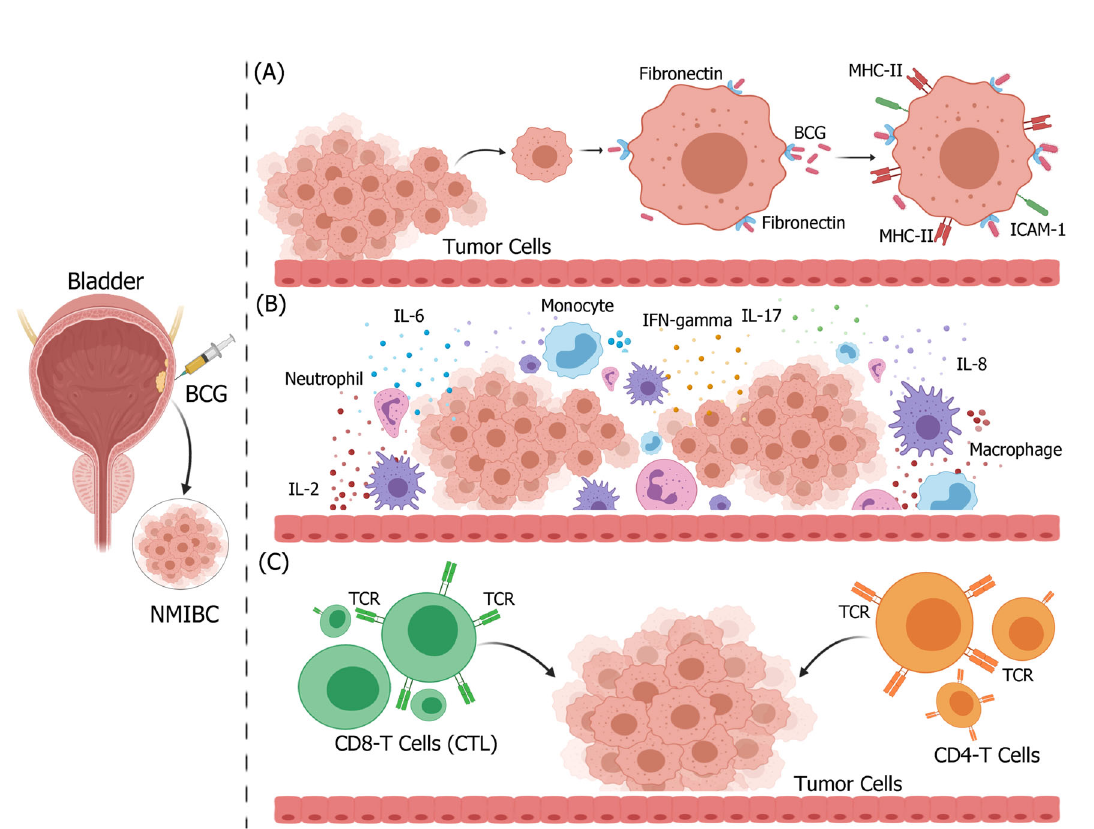
Fig. 3 Possible mechanism of BCG non-speci fi c immunotherapy in non-muscle invasive bladder cancer. BCG attached to the urothelium is internalized by bladder cancer cells, causing direct cytotoxicity of immune system effectors to kill bladder cancer cells. A BCG attaches to the urothelium via fi bronectin and integrin α 5 β 1, and is internalized by bladder cancer cells, owing to oncogenic aberrations that activate macropinocytosis. Following internalization, bladder cancer cells upregulate the expression of MHC-II and ICAM-1. B Various immune cells in fi ltrate bladder tumor tissues, release large amounts of in fl ammatory cytokines and chemokines, and change the tumor microenvironment. C Activated immune cells, such as CD4 and CD8 T cells, are cytotoxic to bladder cancer cells. Figure was created using